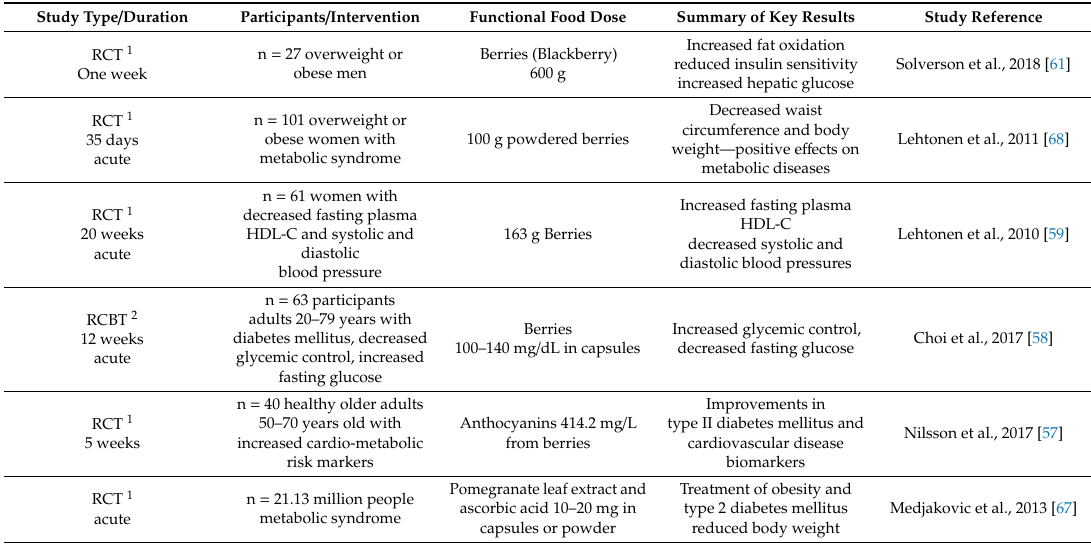
Table 4. Human intervention clinical studies about the possible e ff ects of berries and pomegranate on body weight control, obesity, and its metabolic consequences Summary of Key Results Study